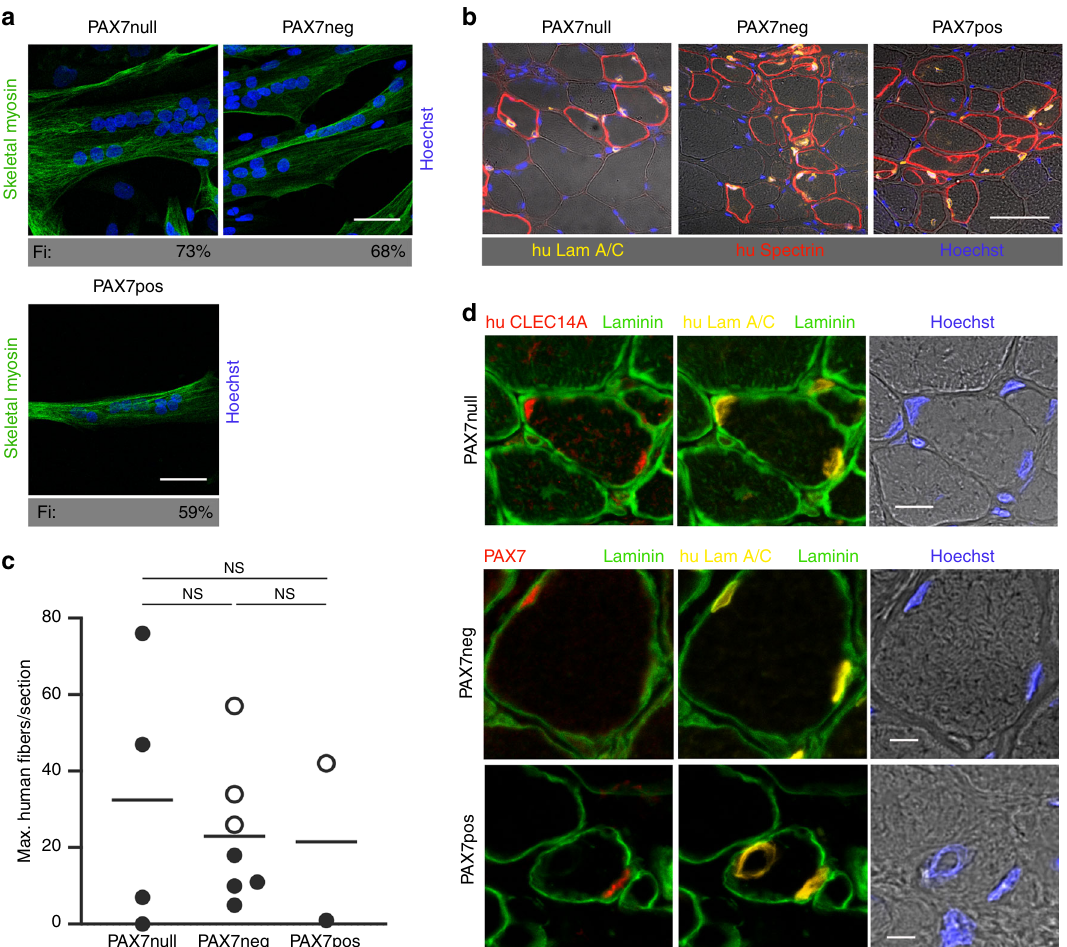
Fig. 3 PAX7-negative cell populations can generate muscle. a PAX7null, PAX7neg, and PAX7pos cells, used in transplantation experiments shown in b , indicate the same differentiation potential (skeletal myosin staining, Fi: Fusion index, Scale bars: 50 µ m). b TA muscle sections from NOG mice demonstrate that 3 weeks after transplantation the PAX7null, PAX7neg, and PAX7pos human cell types contributed to muscle regeneration. Human anti- lamin A/C antibody (yellow) detects only human nuclei and anti-human spectrin antibody is speci fi c for fi bers of human origin (red). Nuclei in blue (Hoechst). Scale bar: 50 µ m. c Quanti fi cation of experiments shown in b . Each dot represents one mouse grafted with the cells indicated below ( n = 4 for PAX7null and n = 7 for PAX7neg). Shown are the values for the section with the highest number of human fi bers for each mouse and the means. Only human muscle fi bers with a diameter > 10 µ m were counted. Mice with > 20 human fi bers/section were additionally analyzed for PAX7 expression. The presence of PAX7-positive satellite cells is indicated by an open circle. The statistical differences between the groups were analyzed by two-tailed t tests, P > 0.05 = NS (not signi fi cant). d Repopulation of satellite cell niche after transplantation: In PAX7null transplants, the satellite cell niche is populated by CLEC14A-positive cells (red, upper row). After transplantation of PAX7neg- and PAX7pos cells, the satellite cell niche is populated by PAX7-positive cells (red, middle, and bottom row). Yellow, human lamin A/C; green, laminin; blue Hoechst. Scale bars: 10 µ m (upper row) and 5 µ